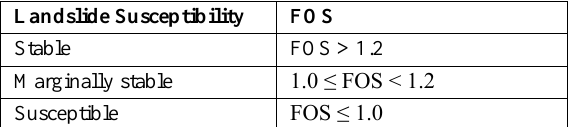
Table 2 . FOS Categorization.